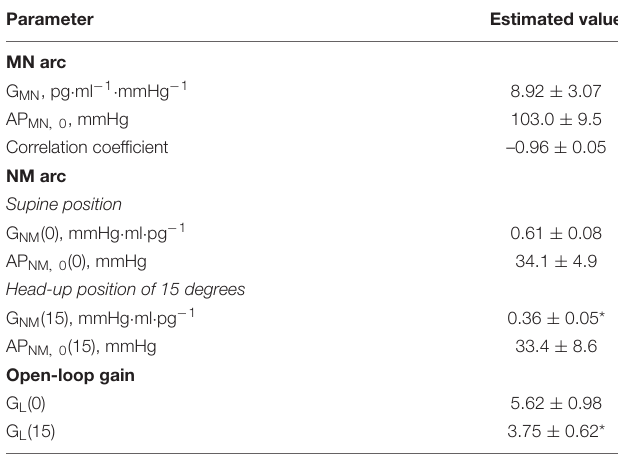
TABLE 2 | Estimation of arterial pressure offset (AP), gain (G) of mechanoneural (MN) and neuromechanical (NM) arcs, and open-loop gain (G L